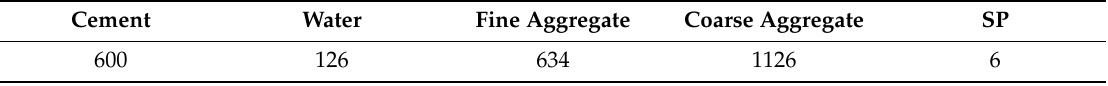
Table 4. Concrete mixes with SCMs